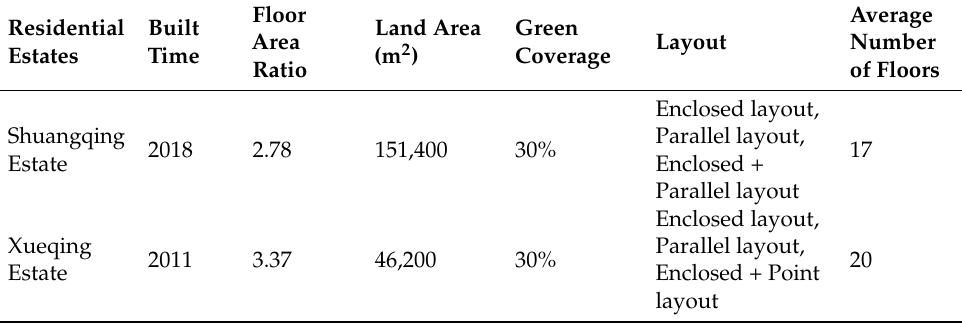
Table 2. Information of the surveyed residential